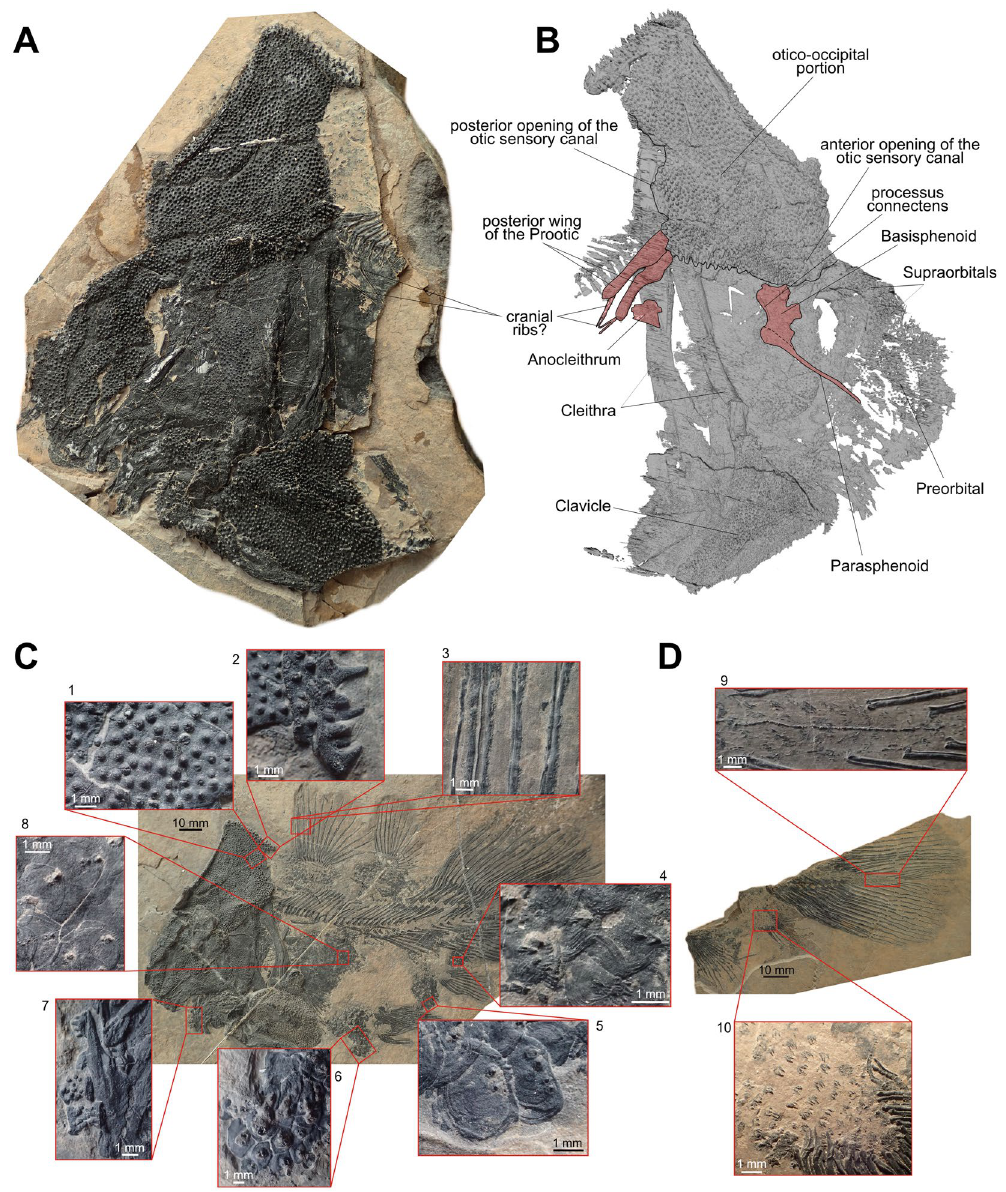
Figure 2. Osteological details of the new coelacanth Foreyia maxkuhni gen. et sp. nov. ( A ) Photo and ( B ) surface CT reconstruction of the skull of the paratype (PIMUZ A/I 4372). ( C ) Tubercles and denticles in the Holotype (PIMUZ A/I 4620) and ( D ) in the paratype (PIMUZ A/I 4372). 1, tubercles on the skull roof. 2, large spine-like tubercles on the posterior margin of the otico-occipital shield. 3, denticles on the fin rays of the first dorsal fin. 4, scales with denticles from the ventral margin of the caudal peduncle. 5, scales with denticles from the anal region. 6, scales with denticles from the belly region. 7, toothed coronoid bones. 8, scales with denticles from the flank. 9, supplementary caudal fin lobe with spiny scales. 10, Scales with denticles from the lobe of the anal